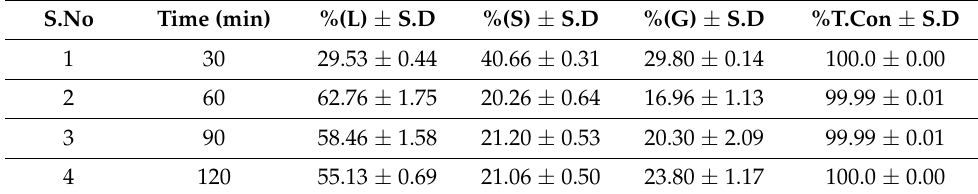
Table 3. Heating Time and Rate Optimization for Catalytic Cracking of Tube Rubber.